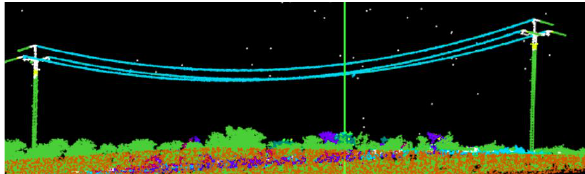
Figure 2. Misclassification of a linear object as a pole. It can be argued that the training data did not have any such vertical feature to be classified and hence the misclassification is a result of aleatoric uncertainty.